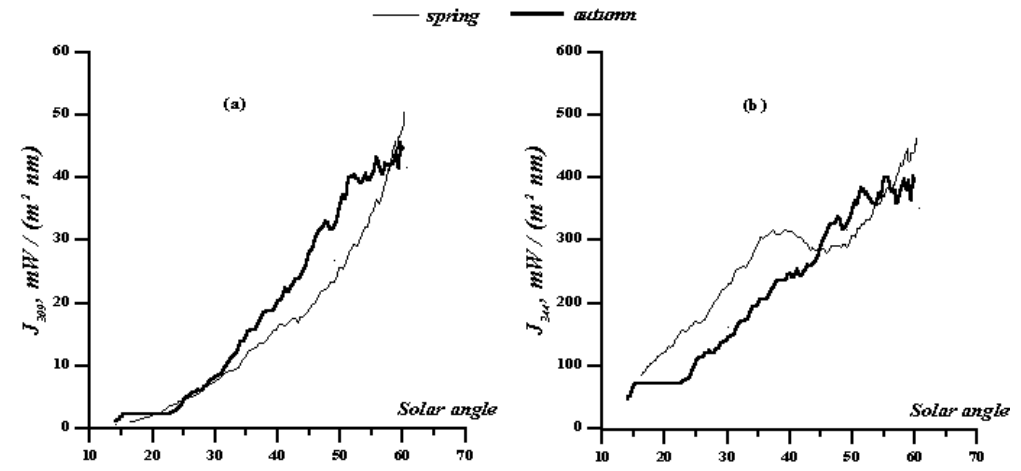
Fig. 2. The averaged, smoothed UVR variations for two half-years depending on the angular altitude of the Sun for the wavelengths of 309nm (a) and 344nm (b) .